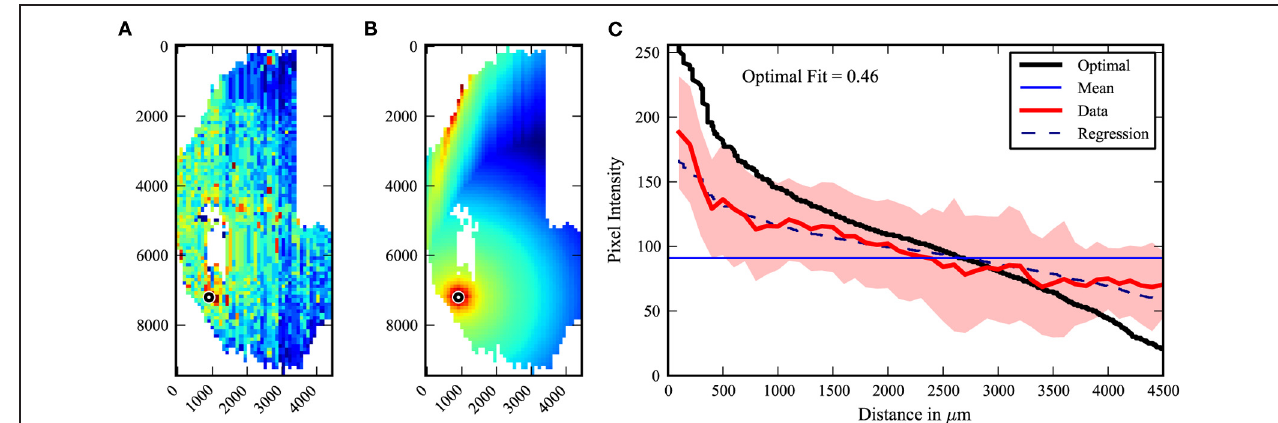
FIGURE 3 | Center-surround quantification model. The degree to which the observed labeling pattern (A) fits a center-surround model was quantified by organizing the observed pixel values into an “optimal” center surround as shown in (B) . (C) The pixel intensities of A and B are then plotted by distance from the injected site, with the mean and standard deviations of the